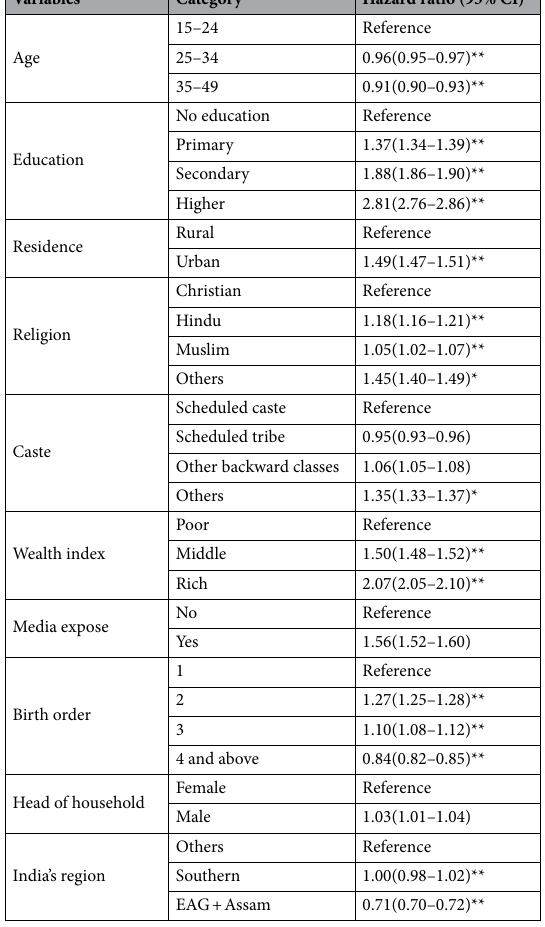
Table 3. Multivariate Cox-proportional hazard model of potential predictors of timing of first antenatal care visit in India. if ** 0.01; & * < 0.05 at the level of significance; EAG: Empowered Action